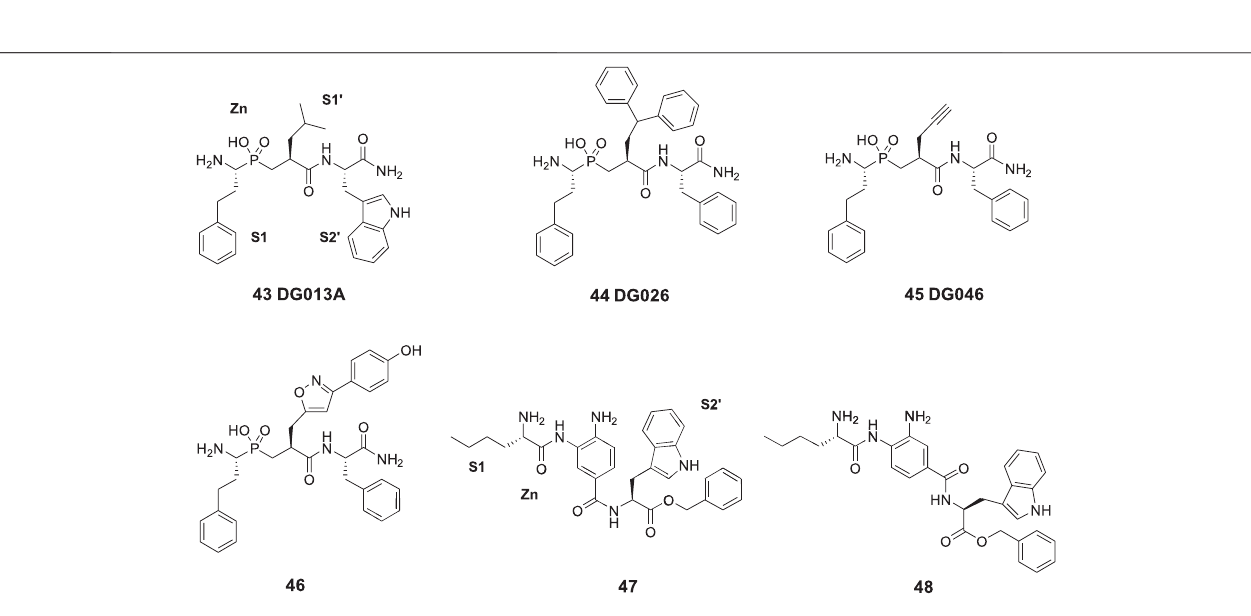
Frontiers in Pharmacology |